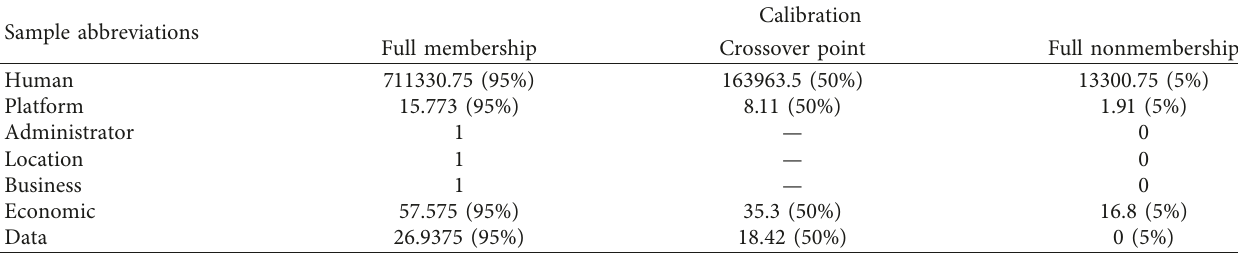
Table 2: Data calibration.